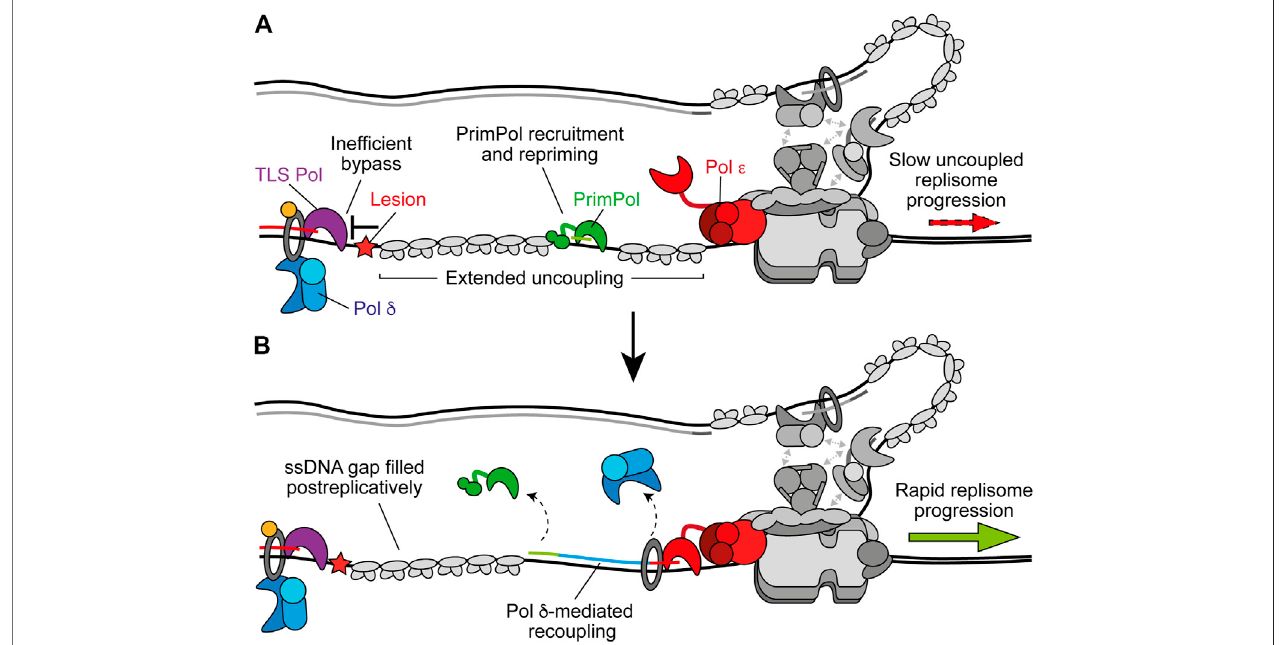
FIGURE5| PrimPol-mediated reprimingrestartsleading-strandsynthesis. (A) Whenreplicase switching andonthe fl yTLSareinef fi cientatbypassingtheleading- strand impediment, extended uncoupling occurs. This stimulates the recruitment of PrimPol to RPA-coated ssDNA downstream and subsequent repriming. Other replisome components are shown in gray for clarity. (B) Following repriming, Pol δ may extend the nascent primer to recouple synthesis to Pol ε and restore rapid replisomeprogressionrates.ThisleavesbehindassDNAgapatthesiteofthelesionwhichmaybe fi lledinpostreplicativelybyTLSortemplateswitching.Synthesis by Pol ε , Pol δ , and PrimPol are shown in red, blue, and green